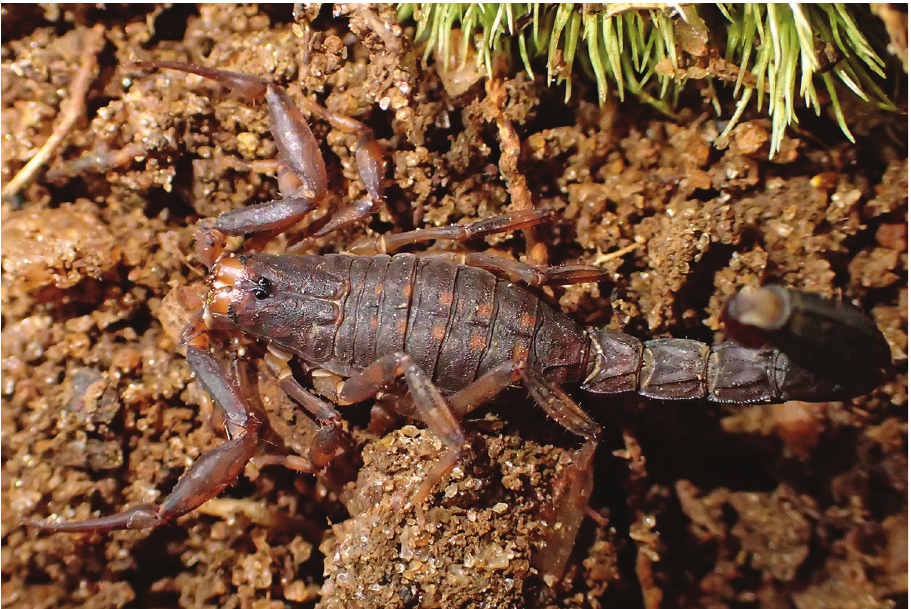
Figure 2. Ananteris guyanensis , female from Saut Sabbat (photo J. Chevalier). eyes surrounded with black pigment. Mesosoma yellowish brown with confluent brown stripes and two longitudinal yellowish stripes. Venter yellowish with spots only on sternite VII. Metasomal segments I to V yellowish brown, with numerous brown spots; segments IV and V reddish, darker than the others. Vesicle reddish yellow without spots, but with some darker areas over the carinae. Chelicerae yel- lowish without variegated spots over their entire surface, and with only a dark thin zone at the base of the fingers; fingers reddish. Pedipalps dark brown with spots on the femur and patella; chelae yellowish; fingers brownish. Legs brownish with fuscous spots. Carapace feebly to moderately granular; anterior margin with a slight median concavity; all furrows moderate to feeble. Tergites moderately granular; me- dian carina moderate to strong in all tergites. Pectinal tooth count 17–16 in female. Sternites almost smooth with moderate elongate stigmata; VII with four vestigial carinae. Metasomal segments with 10-10-10-8-5 crenulate carinae; intercarinal spaces moderately granular; segment V rounded. Telson moderately granular with one ventral carina and with a fairly short and moderately curved aculeus; subaculear tooth strong and spinoid. Pedipalp femur pentacarinate; patella and chelae with a few carinae but moderately crenulate; internal side of patella with only vestigial spinoid granules; all sides moderately to feebly granular; movable fingers with seven oblique rows of granules; only one accessory granule present at the base of each row. Leg tarsus with very numerous fine median setae ventrally; tibial spurs strongly de- veloped on legs III and